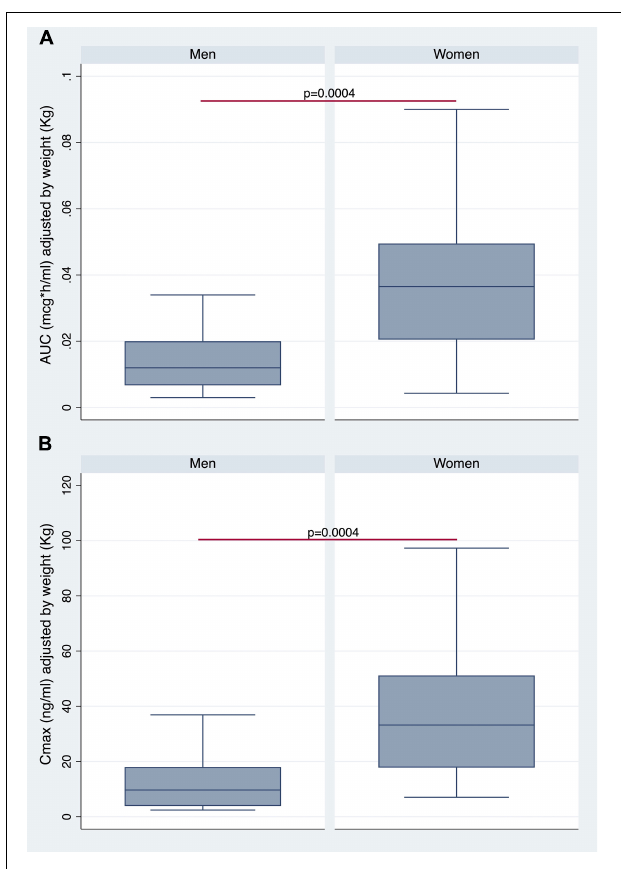
FIGURE 4 | Gender differences in AUC (A) and Cmax (B) adjusted for BW.